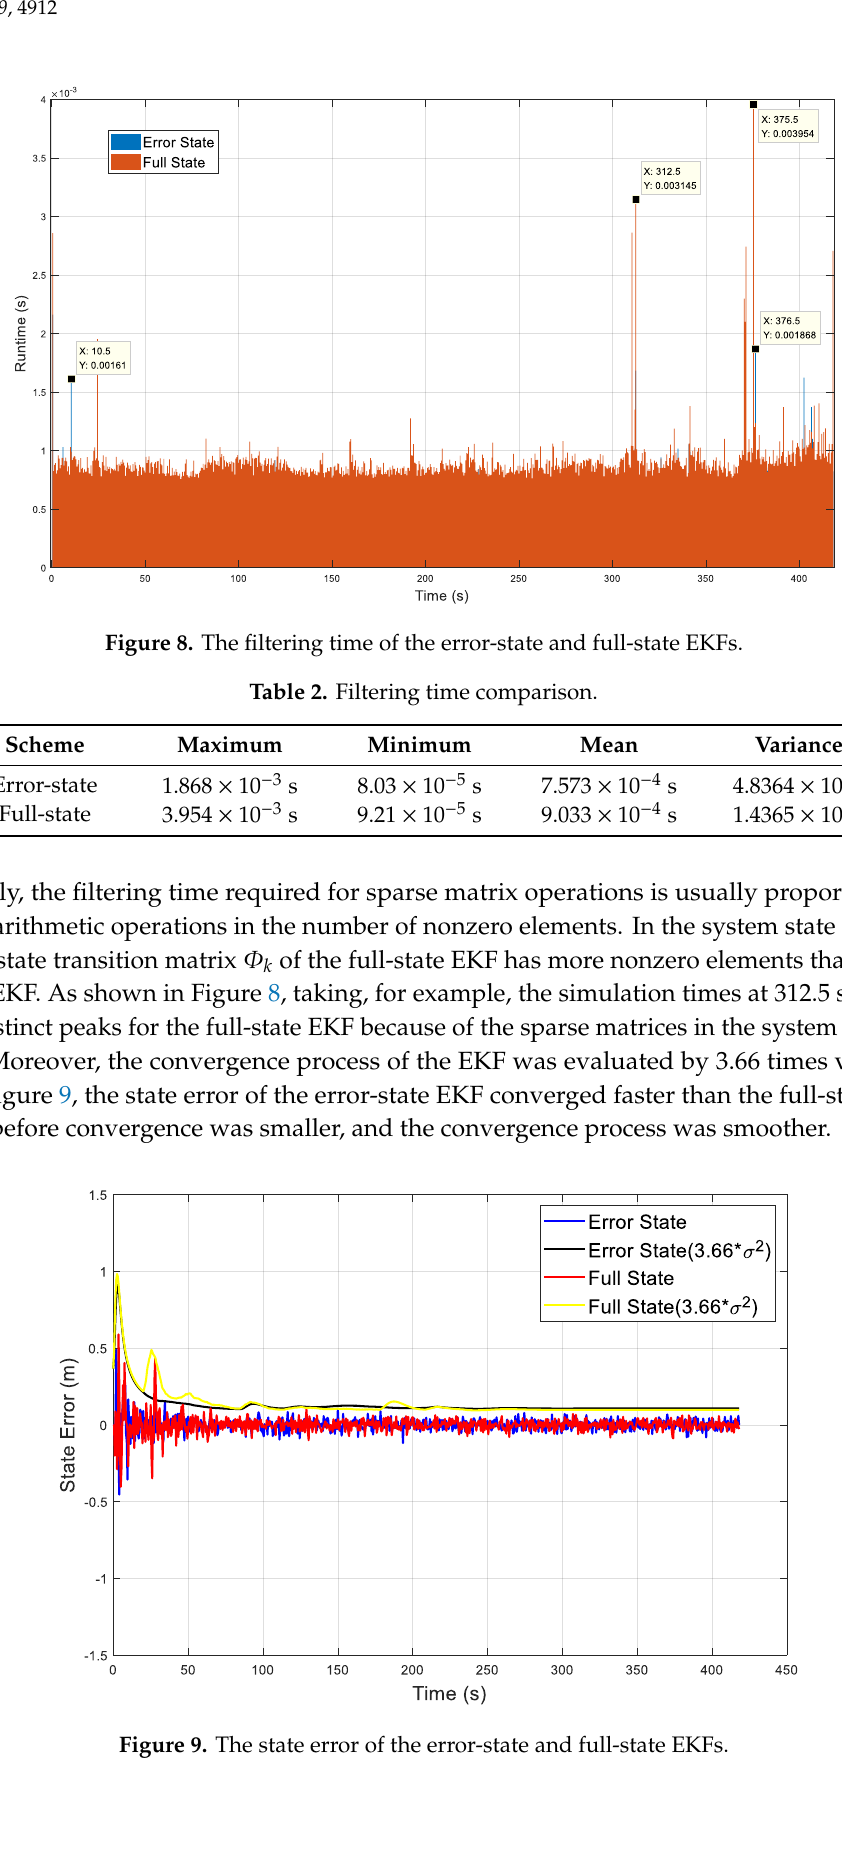
Figure 9. The state error of the error-state and full-state EKFs.